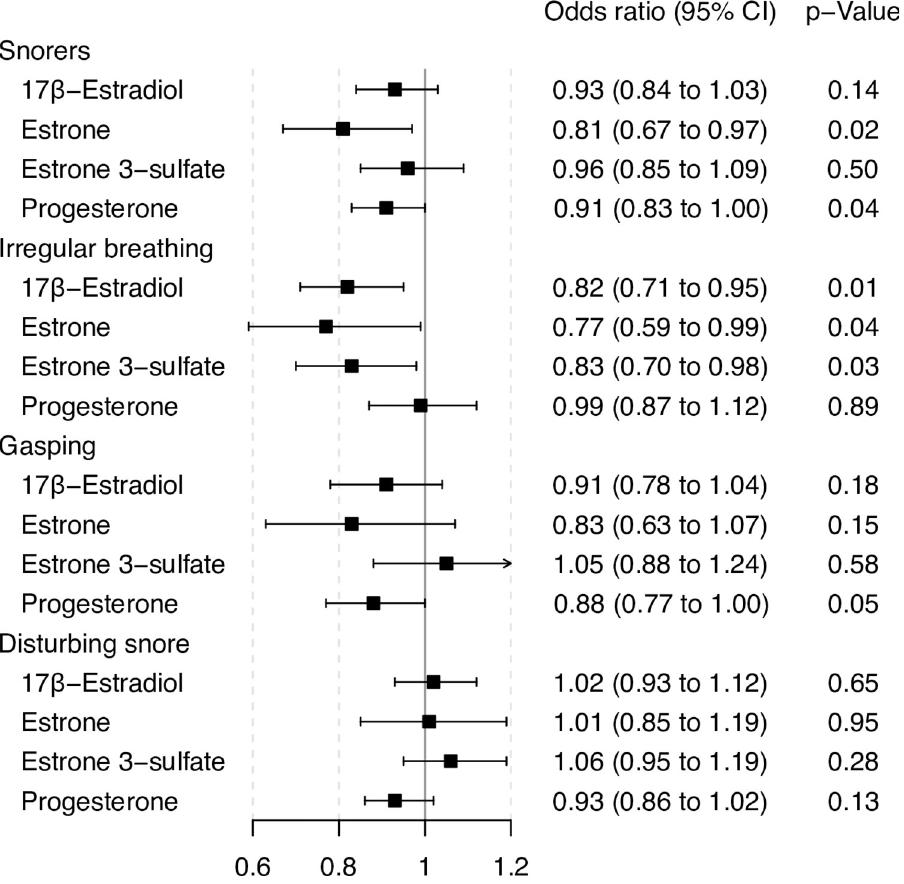
Fig 3. Results of the main analyses, odds ratio and 95% confidence intervals of female sex hormones with obstructive sleep apnea symptoms, adjusted for age, BMI, smoking, age at completed full time education, study center and reproductive aging